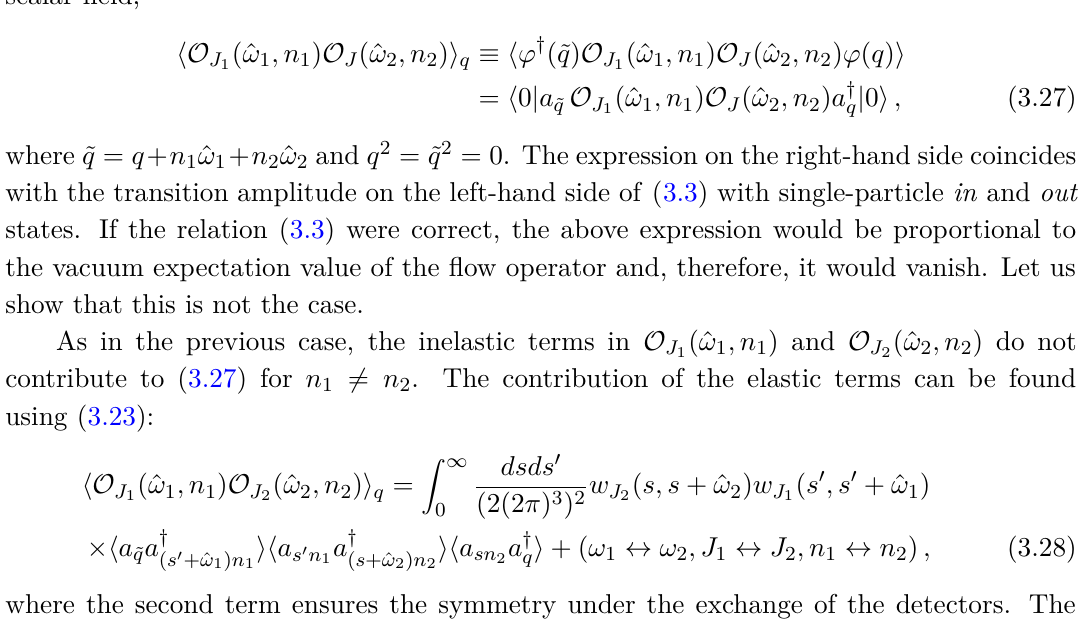
Figure 1 . Cross-talk between the detectors. The grey blobs represent the detectors, the solid line depicts the propagator of a scalar particle, the arrows indicate the direction in which it propagates. scalar